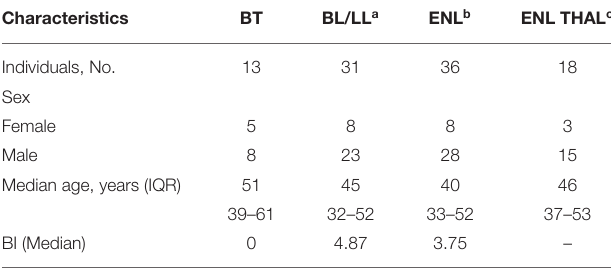
TABLE 1 | Demographic and clinical patient